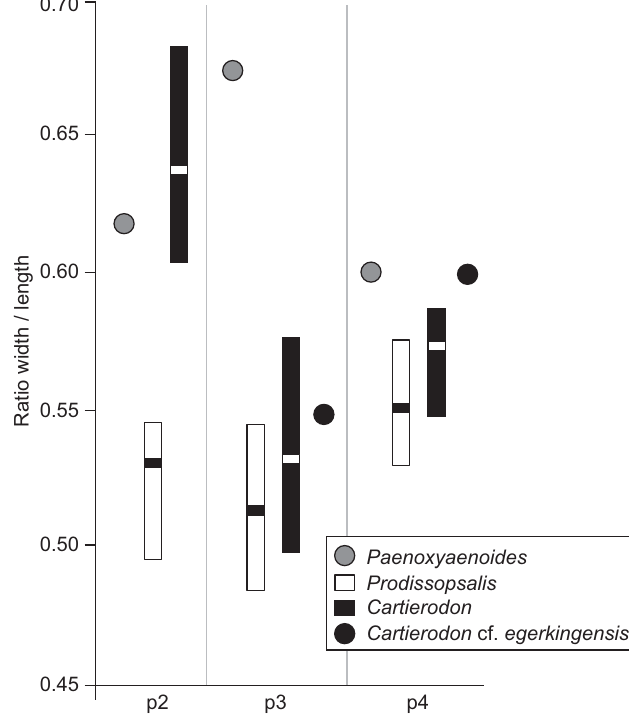
Fig. 4. Comparison of the ratio width/length estimated for the lower pre- molars of Paenoxyaenoides liguritor from late Eocene of France, Quercy Phosphorites (based on Lange-Badré 1979: table 10), Prodissopsalis eocae- nicus from Eocene of Switzerland, Geiseltal-Obere Mittelkohle (MP12) and Geiseltal-Untere Mittelkohle (MP13) (based on Lange-Badré and Haubold 1990: table 3); Cartierodon egerkingensis gen. et sp. nov. from Eocene of Switzerland, Egerkingen γ (MP13?); and Cartierodon cf. egerkingensis from Eocene of France, Lissieu (MP14) (based on Lange-Badré 1972: table